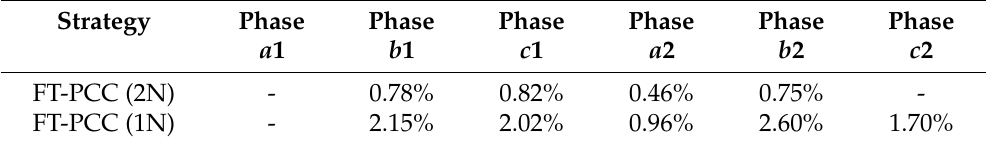
Table 3. Experimental results: current THD for fault-tolerant mode due to an OPF in phase a 1 at 750 rpm.